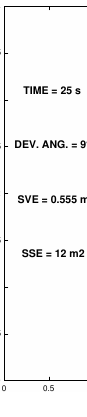
Figure 8. Participant F’s pre-test veering path walked in the longest time (25 s) straight along the shortest line to the final point. As a consequence, also SSE values